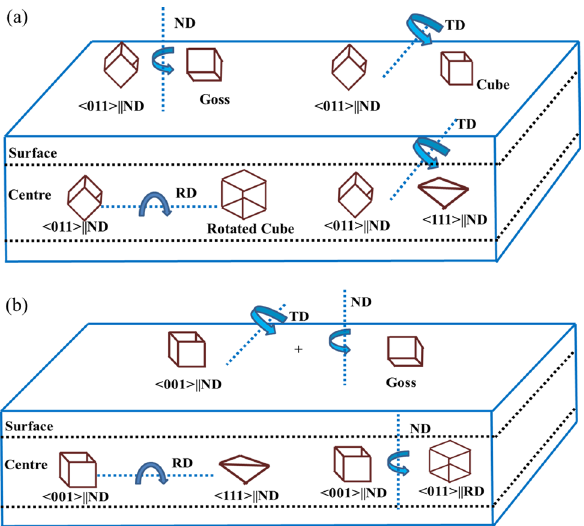
Figure 10. Schematic representation of the major texture components of the hot band and the corresponding plausible evolution from the initial orientations for ( a ) Cast 1 and 3; ( b ) Cast 2, 4 and